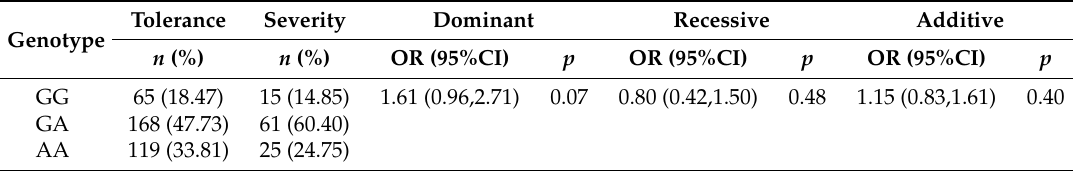
Table 8. Association between CASC8 rs10505477 and platinum-based chemotherapy gastrointestinal toxicity in lung cancers.